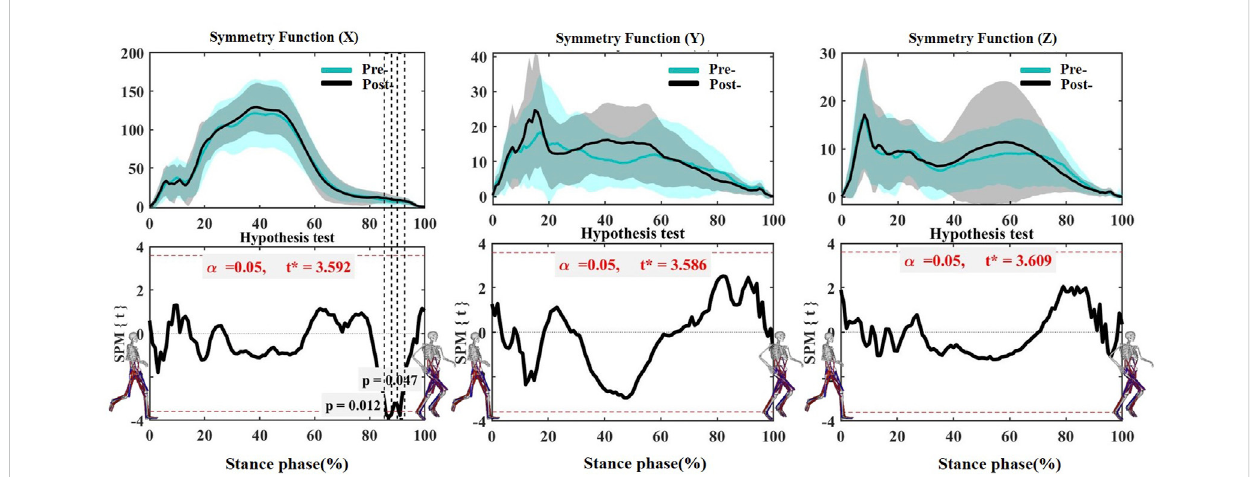
FIGURE 4 ComparingthemeanvaluesofSFofGRFx,GRFy,andGRFzfromallparticipantsbetweenPre-fatigueandPost-fatigue.Note:Pre-isPre-fatigue,and Post-is Post-fatigue. The black dotted boxes represent a signi fi cant difference ( p < 0.05). GRFx: medial-lateral direction of GRF, GRFy: anterior-posterior direction of GRF, GRFz: vertical direction of